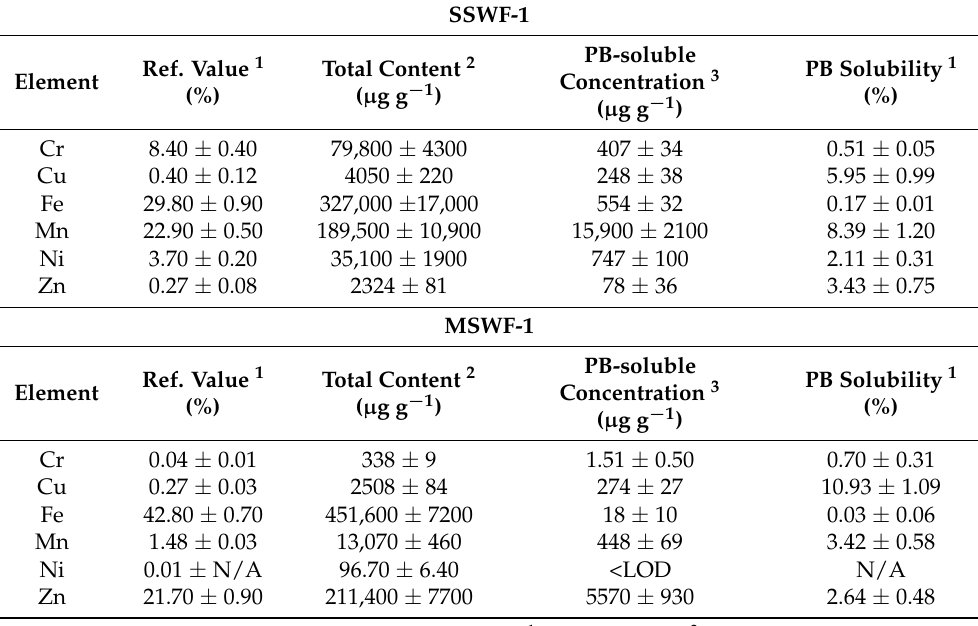
Table 1. Total content ( µ g g − 1 ), PB-soluble concentration ( µ g g − 1 ), and percentage of PB